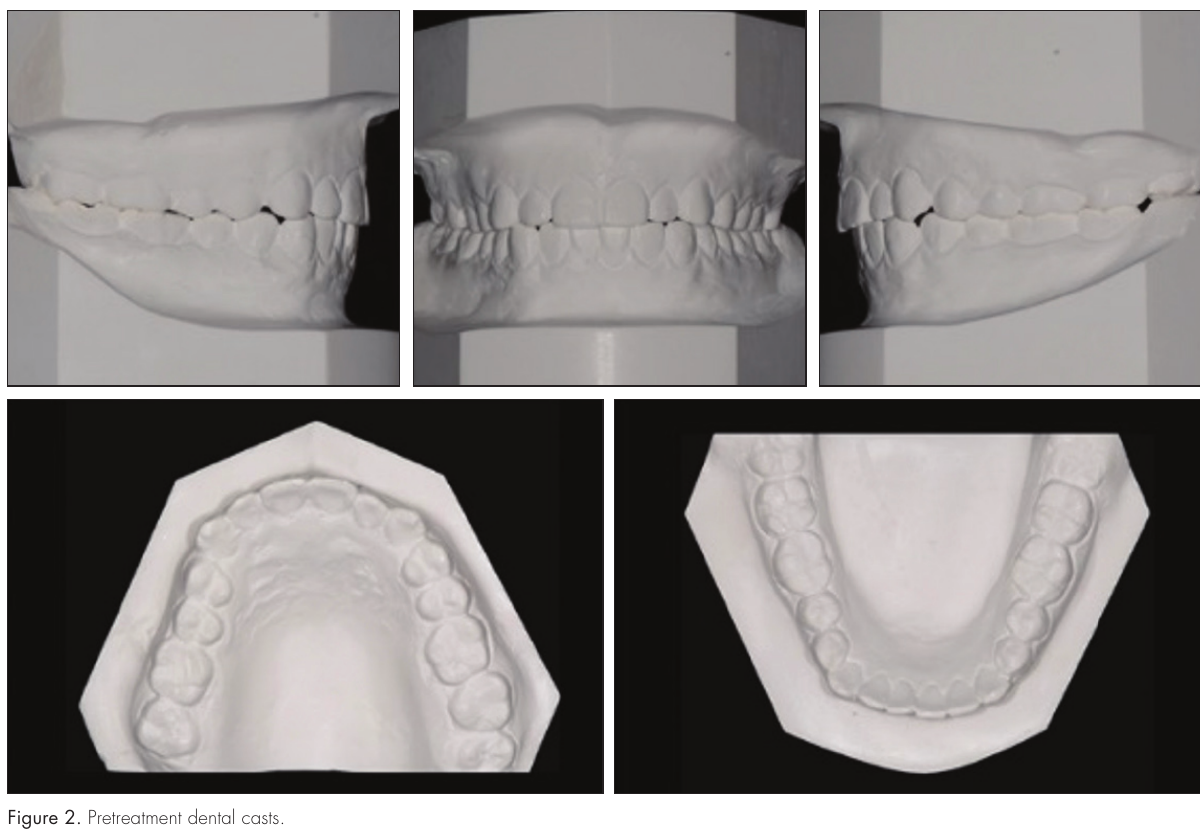
Figure 2. Pretreatment dental casts.